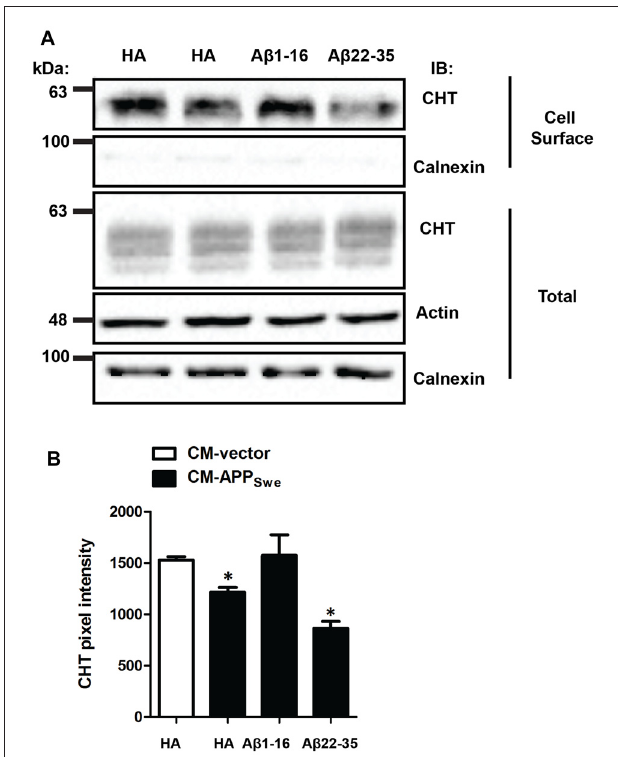
FIGURE 3 | N-terminal A β antibody attenuates A β -mediated inhibition of CHT plasma membrane levels. (A) CM was collected from SY5Y-CHT cells that had been transiently expressing either vector or APP Swe plasmid DNA for 24 h (CM-vector and CM-APP Swe , respectively). CM-vector and CM-APP Swe were incubated with either anti-HA, anti-A β [1–16] or anti-A β [22–35] antibody for 24 h and then added to SY5Y-CHT cells for 24 h. Cells were then washed and placed on ice, and then plasma membrane proteins were biotinylated. Biotinylated proteins were captured using NeutrAvidin agarose, then proteins were solubilized and separated by SDS-PAGE. PVDF membranes were processed by immunoblotting with antibodies recognizing CHT, actin and calnexin. Representative immunoblots show steady-state CHT, actin and calnexin protein levels in total cell lysates (3 lower panels). The top panels illustrate cell surface (biotinylated) CHT and calnexin proteins. The immunoblots shown are representative of data obtained from five independent experiments. (B) Analysis of cell surface CHT protein bands by densitometry reveals that the level of CHT protein at the cell surface is significantly reduced in cells treated with CM-APP Swe containing HA and in cells treated with CM-APP Swe containing anti-A β [22–35] antibody when compared to cells treated with CM-vector or CM-APP Swe containing anti-A β [1–16] antibody. Data are the mean ± SEM of five independent experiments, with statistical analyses performed using a repeated-measures one-way ANOVA with Tukey’s post hoc multiple comparisons test ( ∗ p ≤